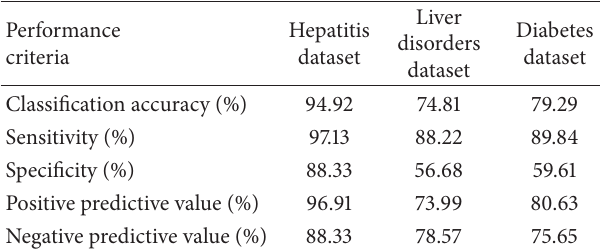
Table 7: Performance of classification for the hepatitis, liver disor- ders, and diabetes